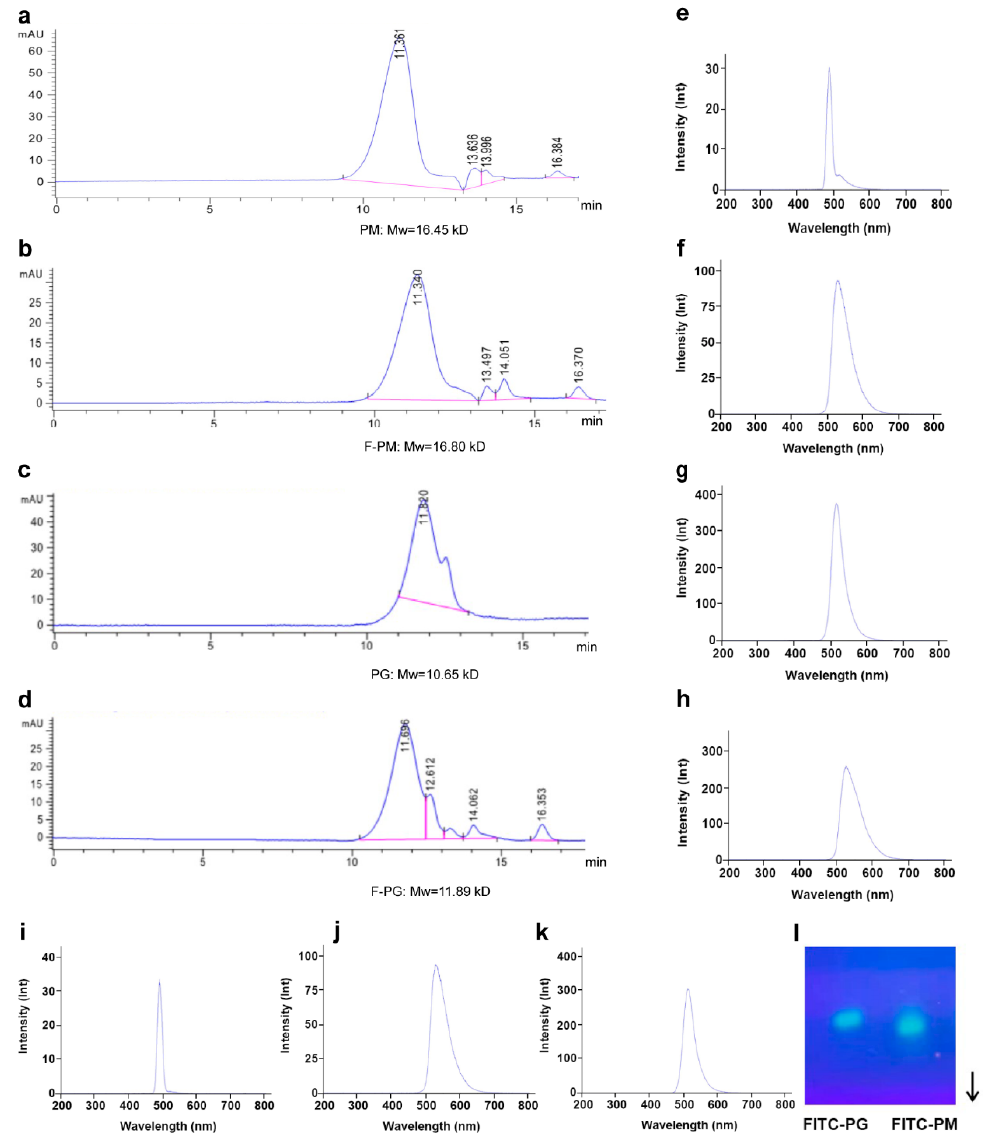
Figure 1. Mw determination by high performance gel permeation chromatography and verification of the fluorescent labeling of PM and PG by agarose gel electrophoresis and fluorescence spectrophotometry. Mw determination of PM ( a ), F-PM ( b ), PG ( c ), F-PG ( d ); fluorescence spectrum of unlabeled PM ( e ), a mixture of FITC and unlabeled PM ( f ), F-PM ( g ), FITC ( h ), PG ( i ), a mixture of FITC and unlabeled PG ( j ), and F-PG ( k ) at an excitation wavelength of 495 nm, lnt is the value of the fitted exponential function of the fluorescence intensity; ( l ) agarose gel electrophoresis pattern. The regression equation of dextran was y = − 0.4207 x + 8.9959 (R 2 = 0.9999).